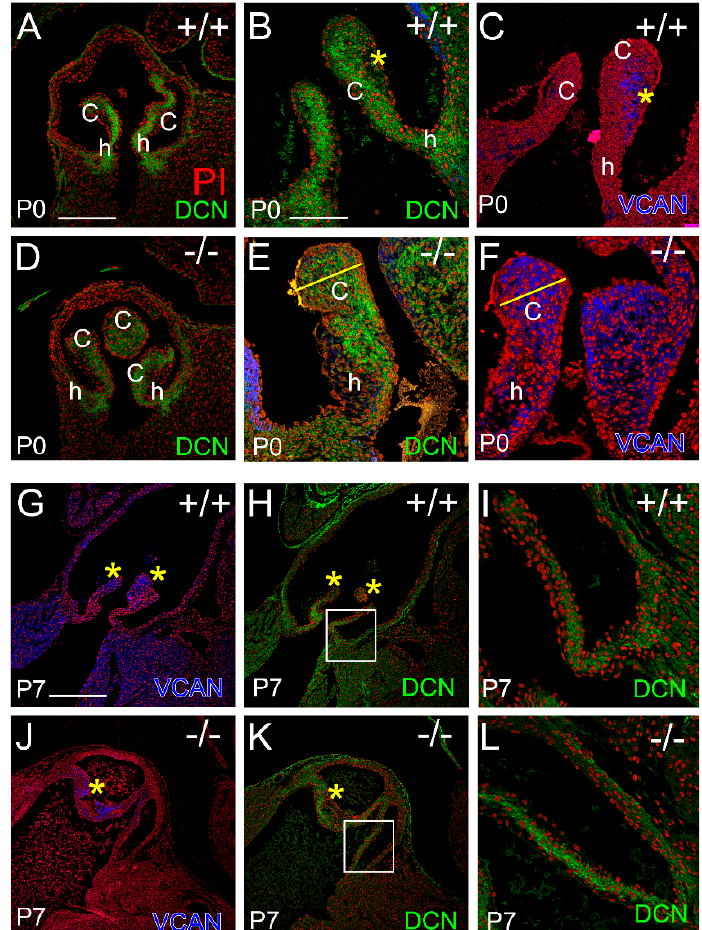
Figure 6. DCN and VCAN exhibit stratified localization in the Adamts5 − / − PV at P7 that display a transient phenotypic rescue and similar to WT. DCN localization (green) at postnatal day 0 (P0; B , D , E ) and P7 ( H , I , K , L ) and VCAN (blue) at P0 ( C , F ) and P7 ( G , J ). c—valve cusp; h—valve hinge region. Yellow asterisks ( B , C , G , H , J , K ) indicate complementary expression patterns of DCN and VCAN while yellow lines ( E , F ) designate overlapping expression patterns of DCN and VCAN. Red-propidium iodide. Bar in ( A ) = 150 μ m and applies to ( D ); Bar in ( B ) = 50 μ m and applies to ( C , E , F , I , L ); Bar in G = 225 μ m and applies to ( H , J , K ).